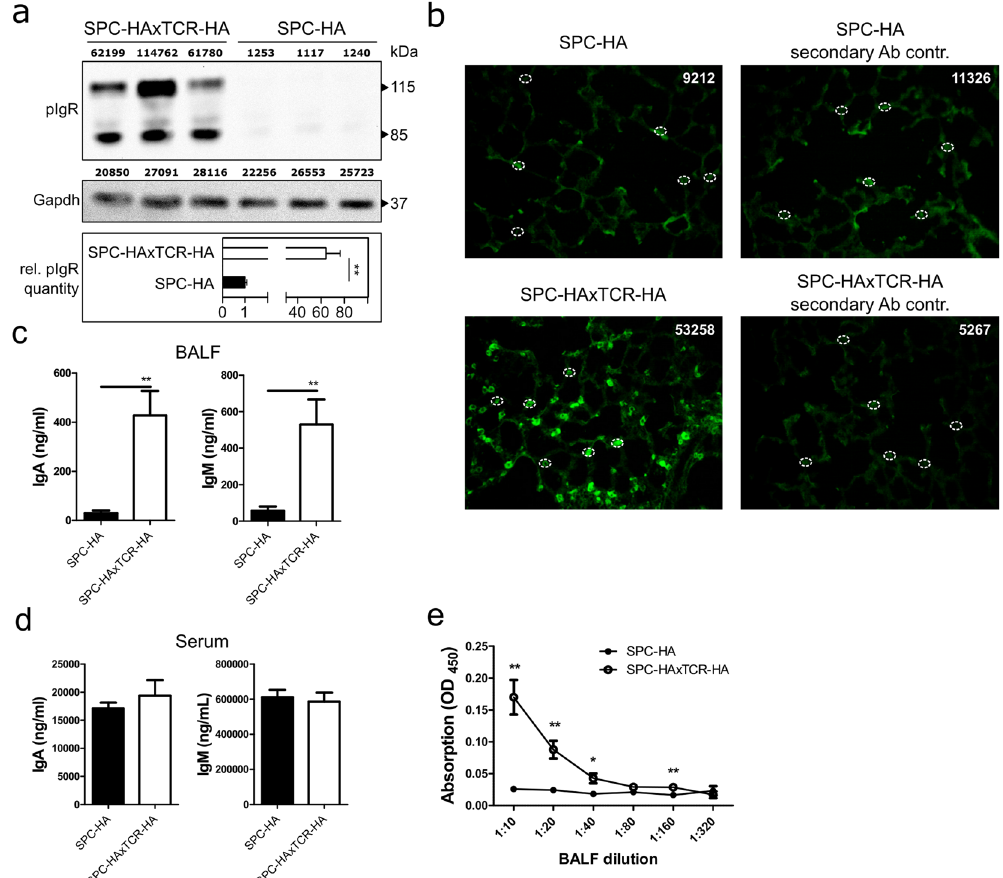
Figure 3. Increased mucosal transport of secretory antibodies in inflamed lungs. ( a ) anti-pIgR and anti- Gapdh immunoblot of 20 µ g protein from whole lung homogenates of SPC-HA (n = 3) and SPC-HAxTCR-HA (n = 3) mice. Densitometric quantification of protein bands is stated in arbitrary units above each lane. Relative pIgR quantity was calculated normalizing densitometric pIgR value to the corresponding Gapdh value and subsequently comparing normalized pIgR values of the SPC-HAxTCR-HA group to the SPC-HA group. Data are representative for at least two individual experiments with similar results. ( b ) Lung tissue sections were stained with anti-pIgR (green), representative alveolar structures from n = 3/group are depicted. White circles illustrate representative densitometrically quantified tissue areas. Calculated total cell fluorescence (CTCF) was determined as: Integrated density of fluorescence-positive cell – (Area of fluorescence-positive cell × mean fluorescence intensity of background signal). Median CTCF of quantified areas in representative images are depicted as white numbers. IgA and IgM levels in ( c ) bronchoalveolar lavage fluid (BALF) and ( d ) serum of SPC-HA and SPC-HAxTCR-HA mice were determined by ELISA. ( e ) Relative secretory IgA concentrations in serial dilutions of BALF samples were determined by ELISA. Results are expressed as the mean optical density (OD) at 450 nm ± SEM, * p < 0.05, ** p < 0.01 (n =